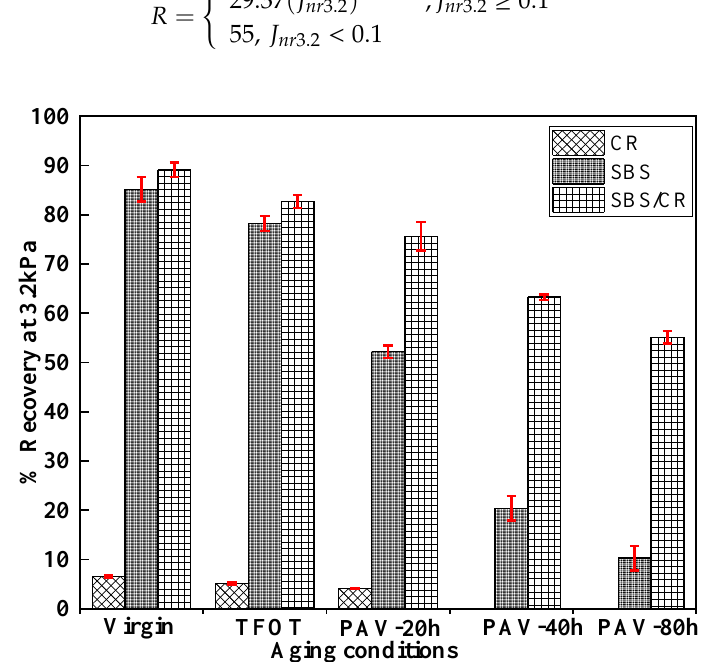
Figure 3. Percent recovery results for all kinds of bitumen at different aging conditions.